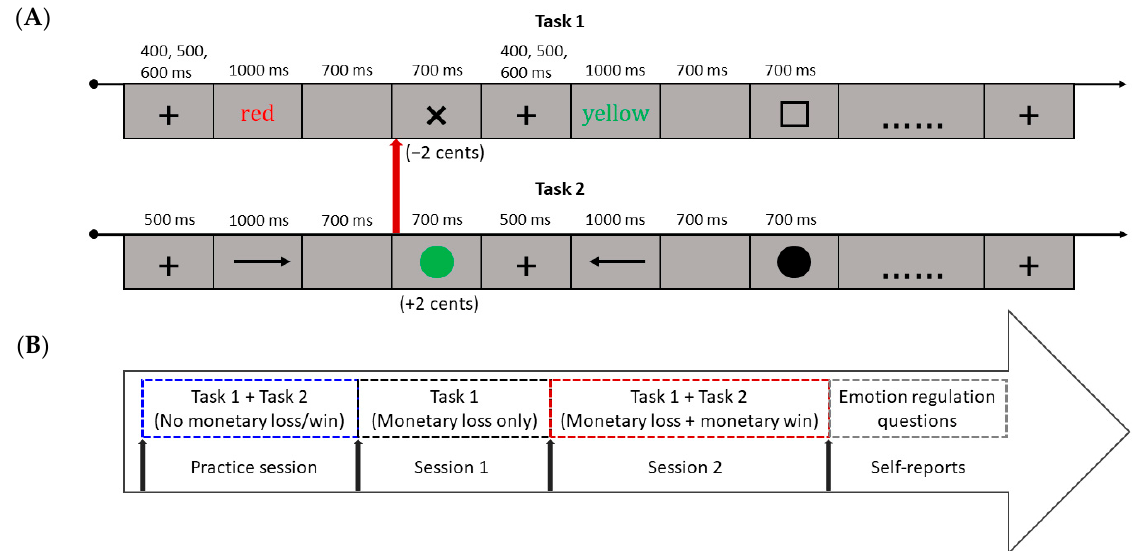
Figure 1. Task and experimental procedure. ( A ) For task 1 (speeded Stroop task), each trial started with a fixation cross, followed by the Stroop stimulus. A blank screen ensued, before the performance-contingent feedback was presented (being either negative or neutral). Negative feedback (a black cross) led to monetary loss, while there was no consequence for neutral feedback (a black square). For task 2 (visual discrimination task), each trial started with a fixation cross, followed by an arrow pointing either to the left or to the right. After that, a blank screen was shown, followed by the performance-contingent feedback (being either positive or neutral). Positive feedback (a green dot) led to monetary win, while there was no consequence for neutral feedback (a black dot). ( B ) General structure of the experimental procedure, consisting of four successive phases.